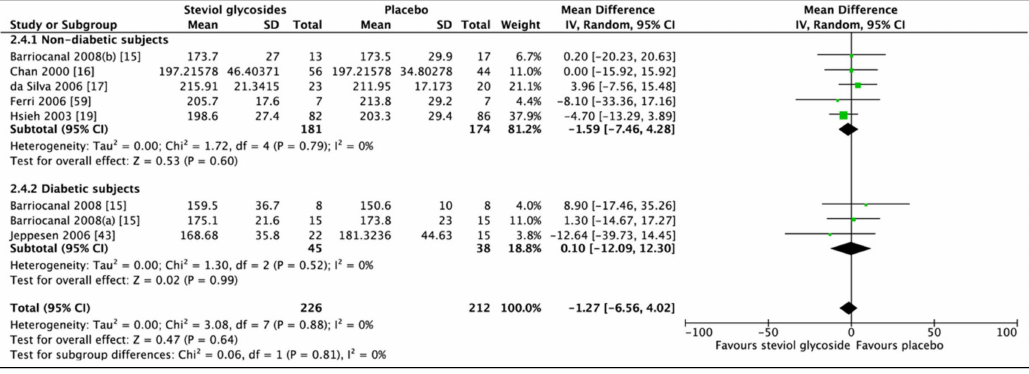
Figure 8. E ff ect of SGs on total cholesterol (mg / dL) CI: confidence interval; MD: mean di ff erence; RCTs: randomized controlled trials; SD: standard